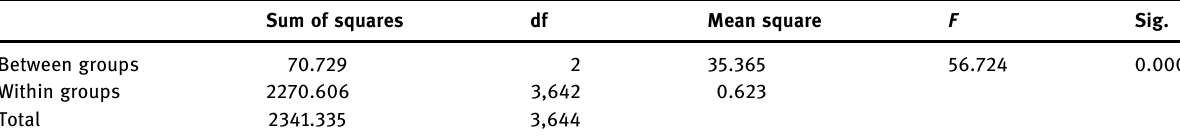
Table 22: Analysis of variance of awareness level by public school and private school Sum of squares df